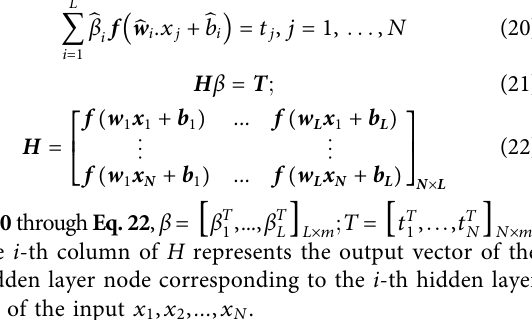
Frontiers in Environmental Science |